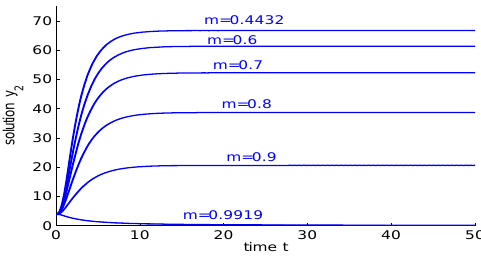
Figure 13: τ = 0 , E * is locally asymptotically stable. Change the values of the refuge m from 1 − R 1 = 0.4432 to 0.9919 = 1 − R 2 , the predator species will